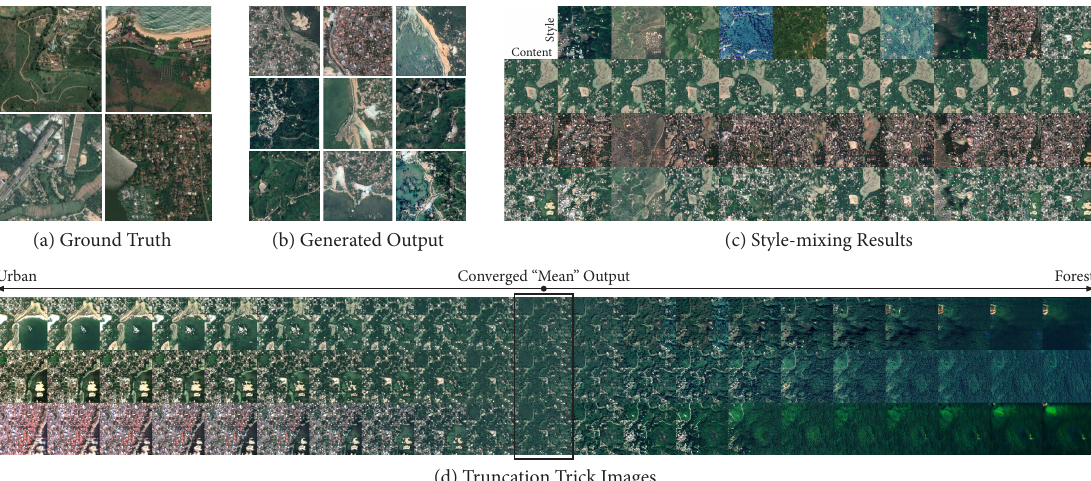
Figure 2. These are the training processes and results of collected satellite images: ( a ) Example of input data. ( b ) Selected output fake images. ( c ) Contents, styles, and mixed results. ( d ) Continuing transforming images